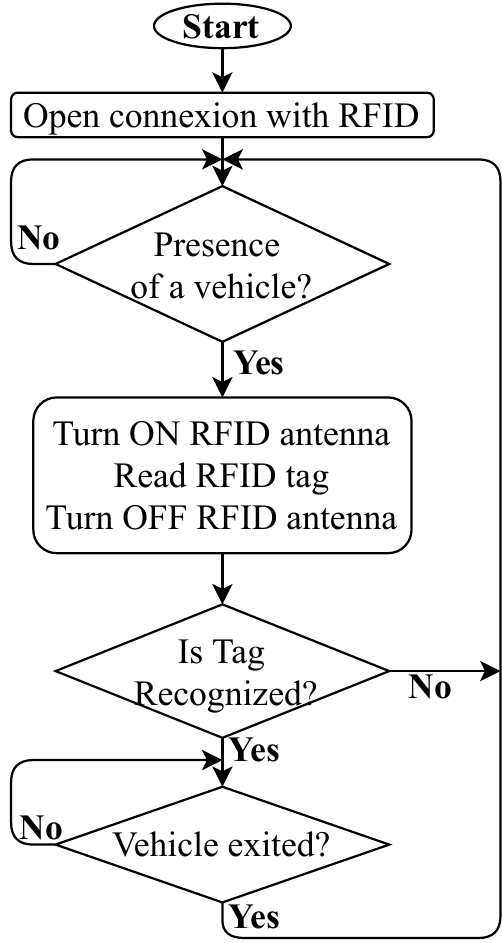
Figure 9. Flowchart of the Parking exit